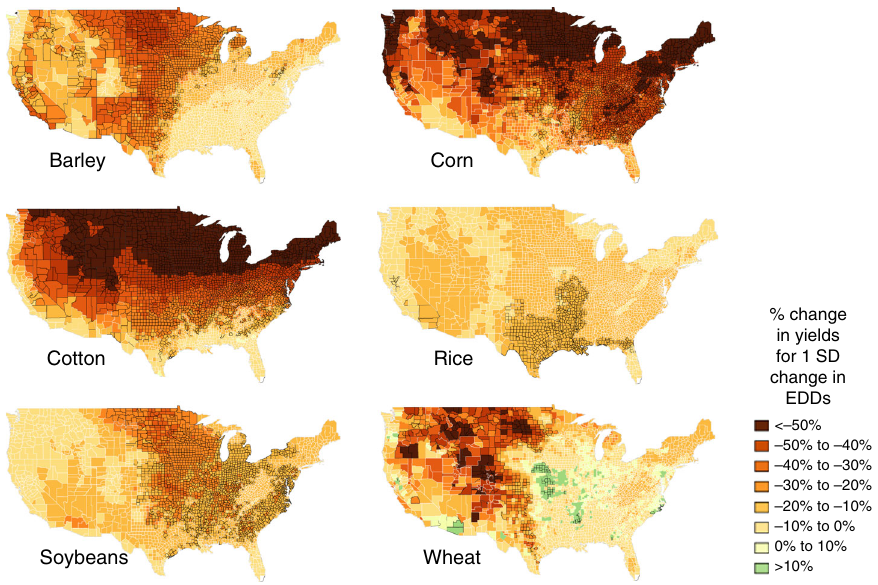
Fig. 1 The effect of extreme degree-days on yields, across counties, and crops. The displayed coef fi cients are for the effect of a 1 standard deviation change in extreme degree-days (EDDs) on log yield, interpretable as the fractional effect on yields. The response to extreme temperatures is predicted even in areas where the crop is not currently grown. Each crop has a different growing season and extreme degree-day cut-off, so that the model coef fi cient is normalized by a different standard deviation per crop (240 EDDs/SD for barley, 65 for corn, 40 for cotton, 63 for rice, 64 for soybeans, and 82 for wheat). County outline color indicates the con fi dence level (solid black outline: >95% of posterior draws have the same sign; thin white outline: <67% of posterior draws have the same sign).